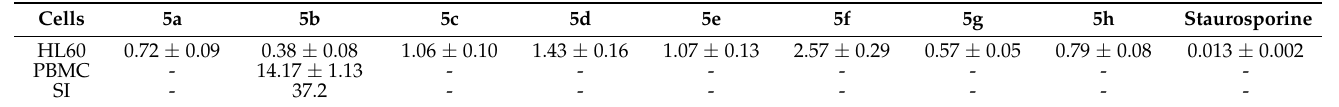
(µM) results against acute myeloid leukemia cells HL-60 PBMC 50